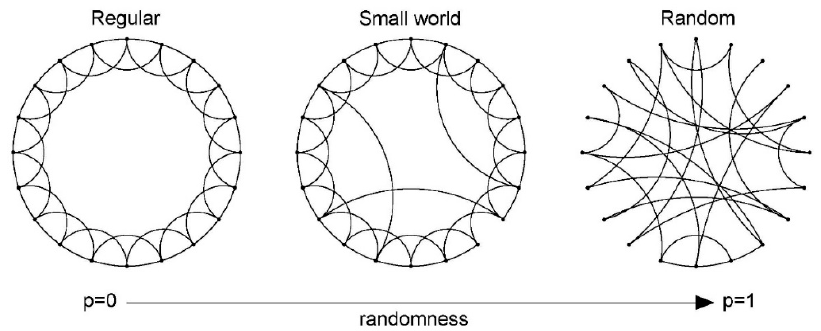
Figure 1. Example of the small-world model.